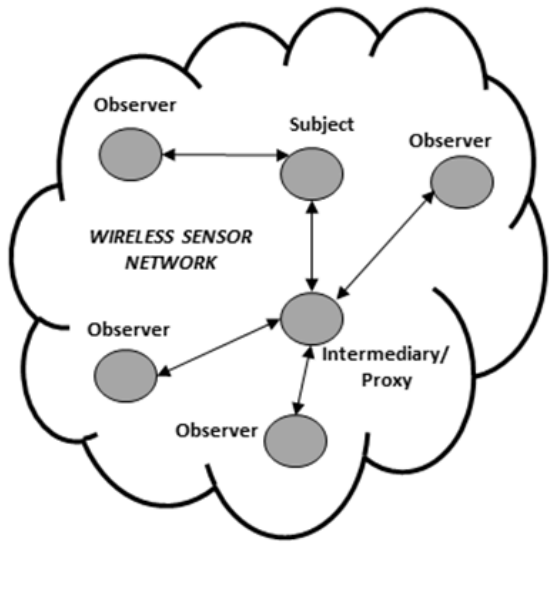
Figure 2. Architecture of the CoAP observer model.